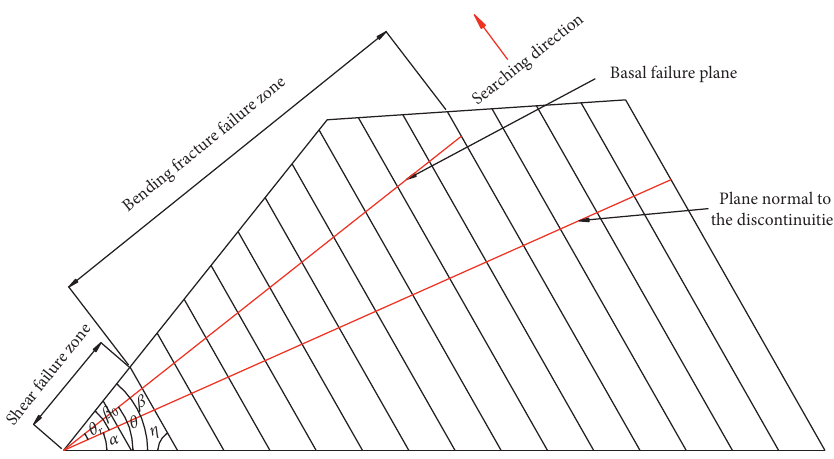
Figure 2: Searching